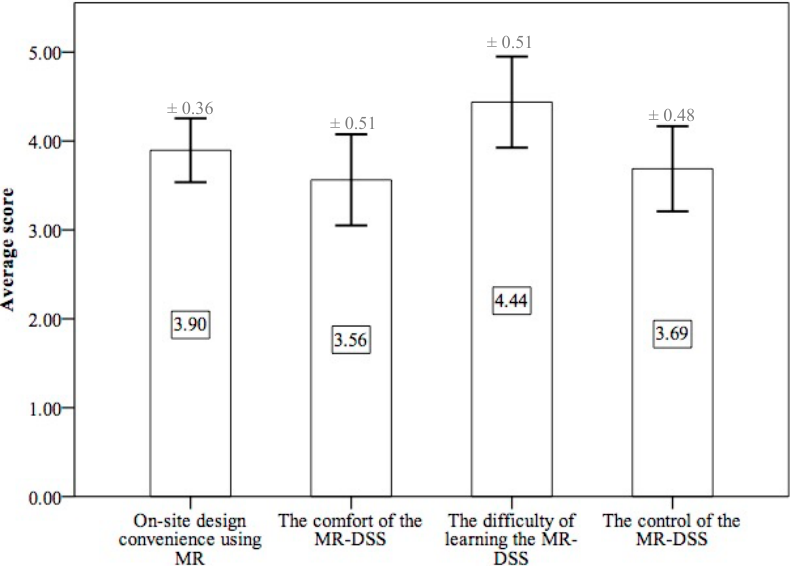
Figure 14. The mean and standard deviation of the score for the on-site design convenience using MR, the comfort of the MR-DSS, the difficulty of learning the MR-DSS, and control of the MR-DSS.